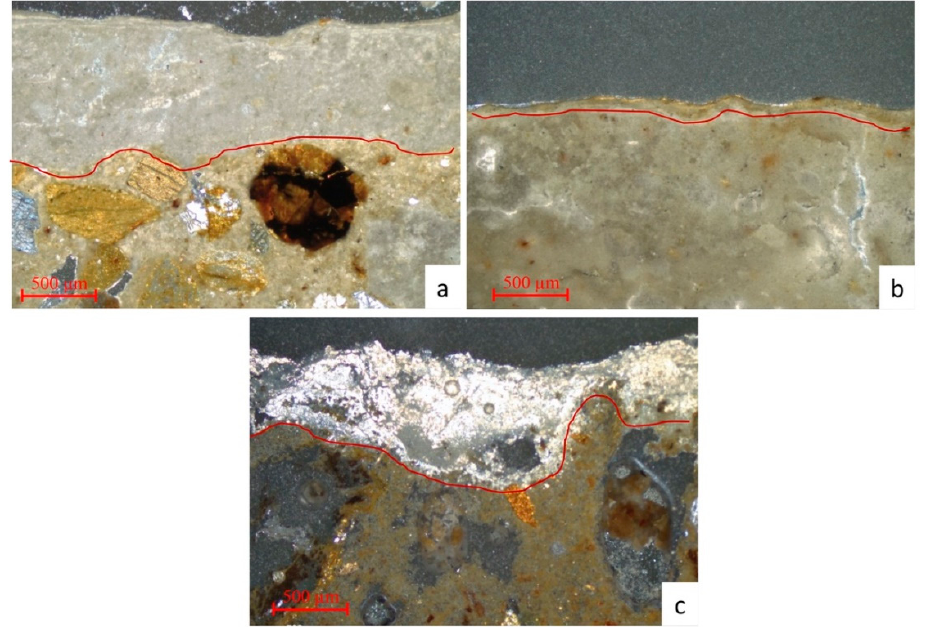
Figure 4. Crossed polarized light images of ( a ) the niche, a thin white Ca lime layer overlapping the plaster where feldspars, pyroxenes, and iron oxides are visible; ( b ) the recumbent figure, two finishing Ca lime layers are shown; ( c ) detail of the pediment where a thin white preparatory layer with isotropic aspect overlaps the tuff rock